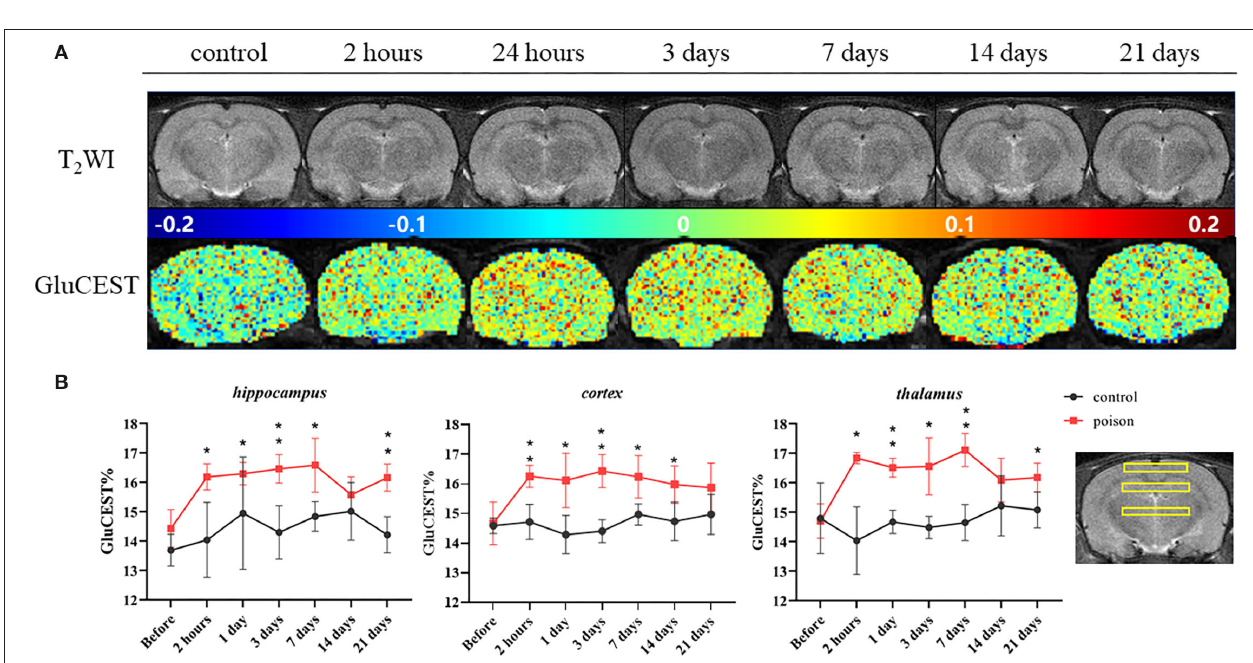
FIGURE 4 | Representative T 2 WI images and GluCEST map of the target-level (A) and regional GluCEST values (B) at different time points before and after CO exposure. * p < 0.05, ** p < 0.01.